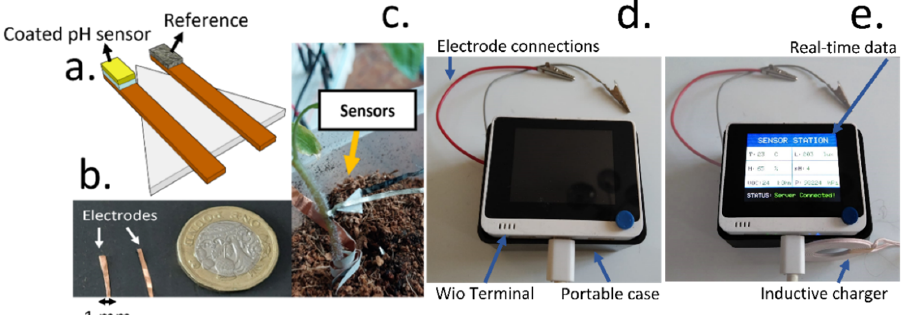
Figure 6. ( a ) Schematic representation of the implantable probe that was inserted inside tomato stems. To improve the implantation, the 1 mm wide electrodes were glued onto a propylene substrate. ( b ) Picture of the pristine copper electrodes prior implantation. A size comparison with a coin is shown, to evidence the low dimensions of the electrodes. Both electrodes were modified with RuO x and Ag/AgCl for the monitoring of pH. ( c ) Final device configuration involving the implanted electrodes inside tomato stems for the monitoring of plant pH. ( d ) Picture of the final device involving a Wio Terminal device, connected to an inductive charger as a power supply, as well as the voltage metre and BME680 environmental sensor (enclosed inside a box). Electrode connections were used to measure the OCP signal from the working and reference electrodes. ( e ) Upon connecting the inductive chargers to the Wio Terminal device, which could also be achieved using a mobile phone, the Wio Terminal can be used without a battery.